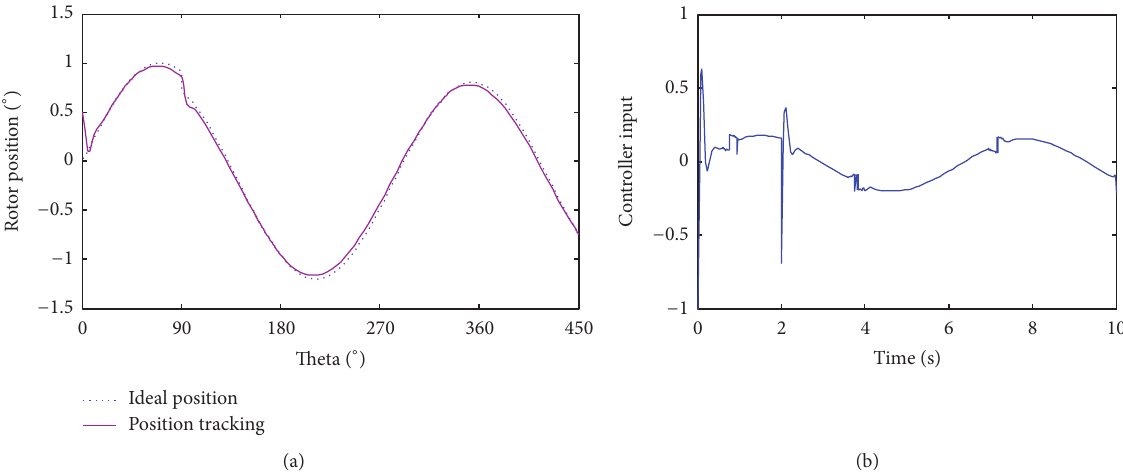
Figure 10: Simulation results of the backstepping SMC when the load is applied. (a) Position tracking. (b) Control